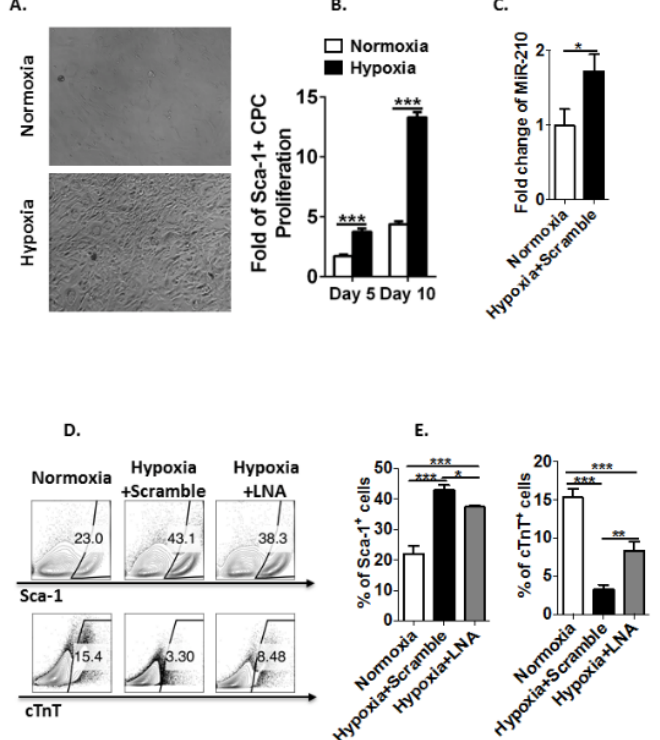
Figure 4. Hypoxia induces microRNA-210 expression in Sca-1 + CPCs and inhibits their differentiation to cardiomyocytes ex vivo. ( A ) Bright-field images of Sca-1 + CPCs cultured under normoxia and hypoxia. ( B ) Fold change of Sca-1 + CPC proliferation under normoxia and hypoxia. Data are presented as the mean ± SEM (n = 3). ( C ) Quantitative RT-PCR analysis of microRNA-210 expression in Sca-1 + CPCs cultured under the indicated conditions. Data are presented as the mean ± SEM (n = 3). ( D ) Representative flow plots showing the surface Sca-1 staining and intracellular cTnT staining of Sca-1 + CPCs after differentiation into cardiomyocytes. ( E ) Quantification of the flow plots presented in (D). Data are presented as the mean ± SEM (n = 3). * p ≤ 0.05, ** p ≤ 0.01 and *** p ≤ 0.001. LNA: LNA-anti- miR-210. 4. Discussion The compelling evidence of the present study demonstrates that fetal hypoxia regulates CPC proliferation and differentiation as well as restrains cardiomyocyte maturation to impair heart development and function after birth with a gender-related difference. To buttress this argument, analysis of cardiac cell population reveals that prenatal hypoxia causes more adverse effects on male offspring than on female ones. In addition, echocardiography indicates that prenatal hypoxia leads to a stronger reduction of IVSd and the ejection time and a greater increased heart rate in male offspring than in female ones. Thus, prenatal hypoxia impedes heart development and impairs heart function with a gender-related difference in mouse young adult offspring. Consistency with the previous studies was that prenatal exposure to hypoxia impairs heart function in later adult life with a gender-related difference [35–37]. Moreover, the present study has disclosed that hypoxia upregulates microRNA-210 expression in Sca-1 + CPCs and blockage of microRNA-210 with LNA- anti-microRNA-210 significantly promoted differentiation of Sca-1+ CPCs into cardiomyocytes. Cardiac development adheres to a stem cell paradigm and endogenous CPCs can generate all the major functional cells for cardiac myogenesis [14,16–18,32]. Previous studies have reported that oxygen levels play a critical role in stem/progenitor cell-fate decisions and cardiac development [19,20,38–40]. Non-physiological hypoxia, as a major challenge to fetuses during the gestation due to the reduction in oxygen delivery to the developing fetus, has been reported to increase the occurrence